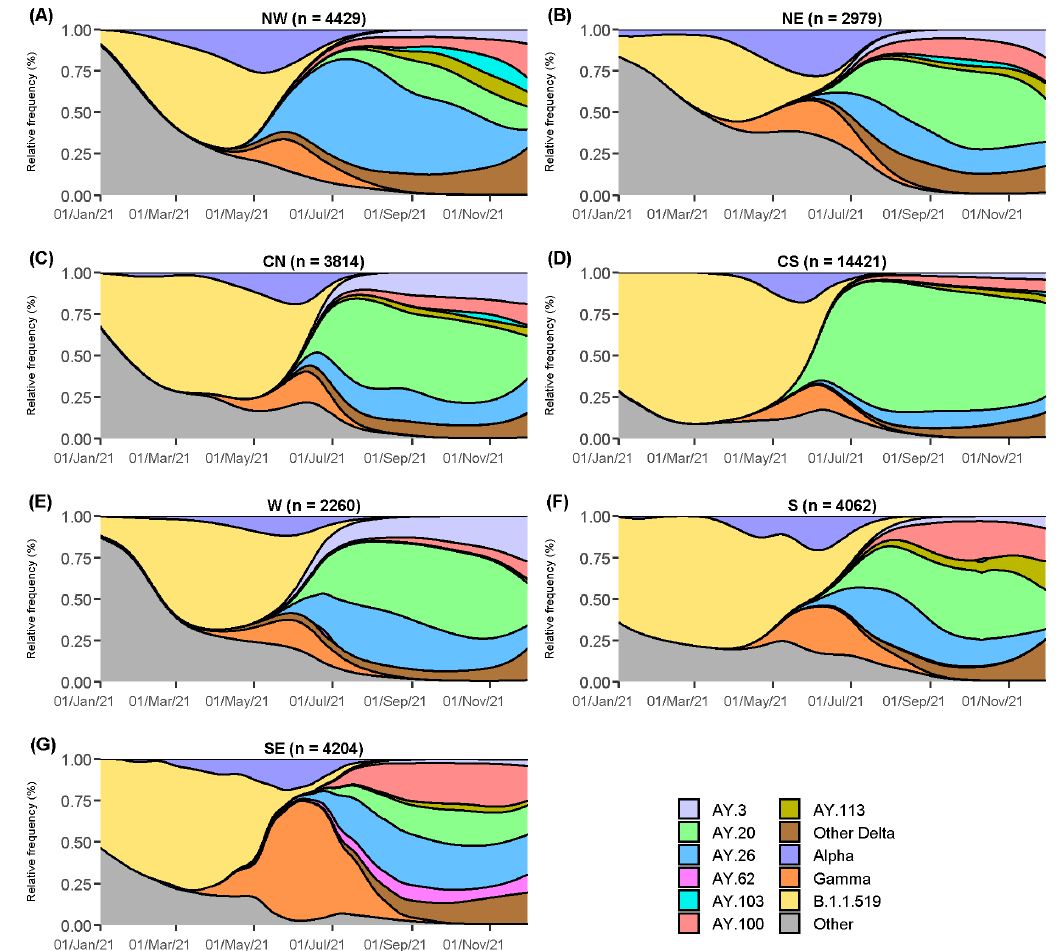
Figure 2. Density plots of relative lineage distribution by geographical region, considering sequences from January to November 2021. ( A ) Northwest, ( B ) Northeast, ( C ) Central North, ( D ) Central South, ( E ) West, ( F ) South, and ( G ) Southeast.